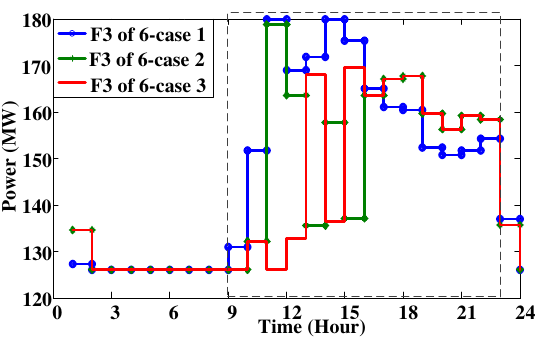
Fig. 11 Comparisons of the wind curtailment of IEEE 24-bus system